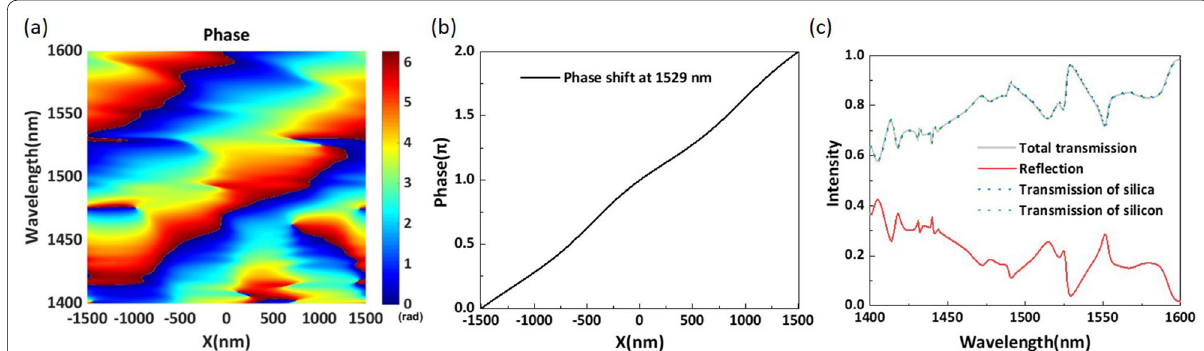
Fig. 4 a Simulated phase shift of the metasurface along the x -direction in a complete period for the wavelength range of 1400–1600 nm. b Simulated phase distribution along the x -direction at a wavelength of 1529 nm. c Simulated intensities of the transmitted and reflected